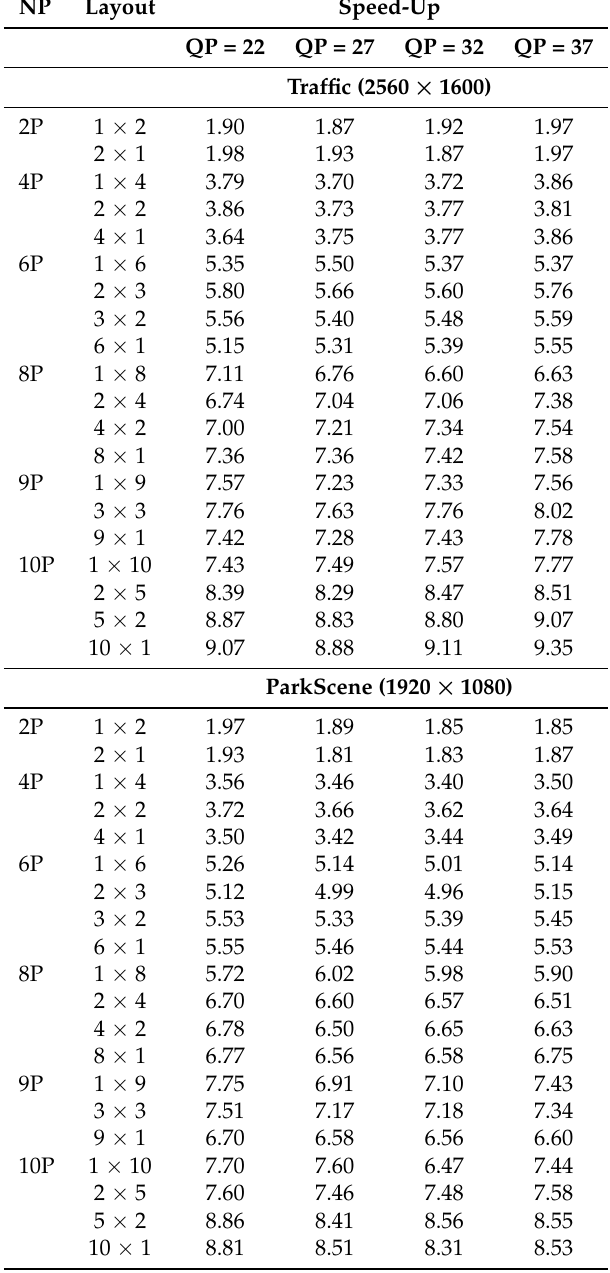
Table 5. Speed-up evolution for high-resolution video sequences for the tile-based parallel